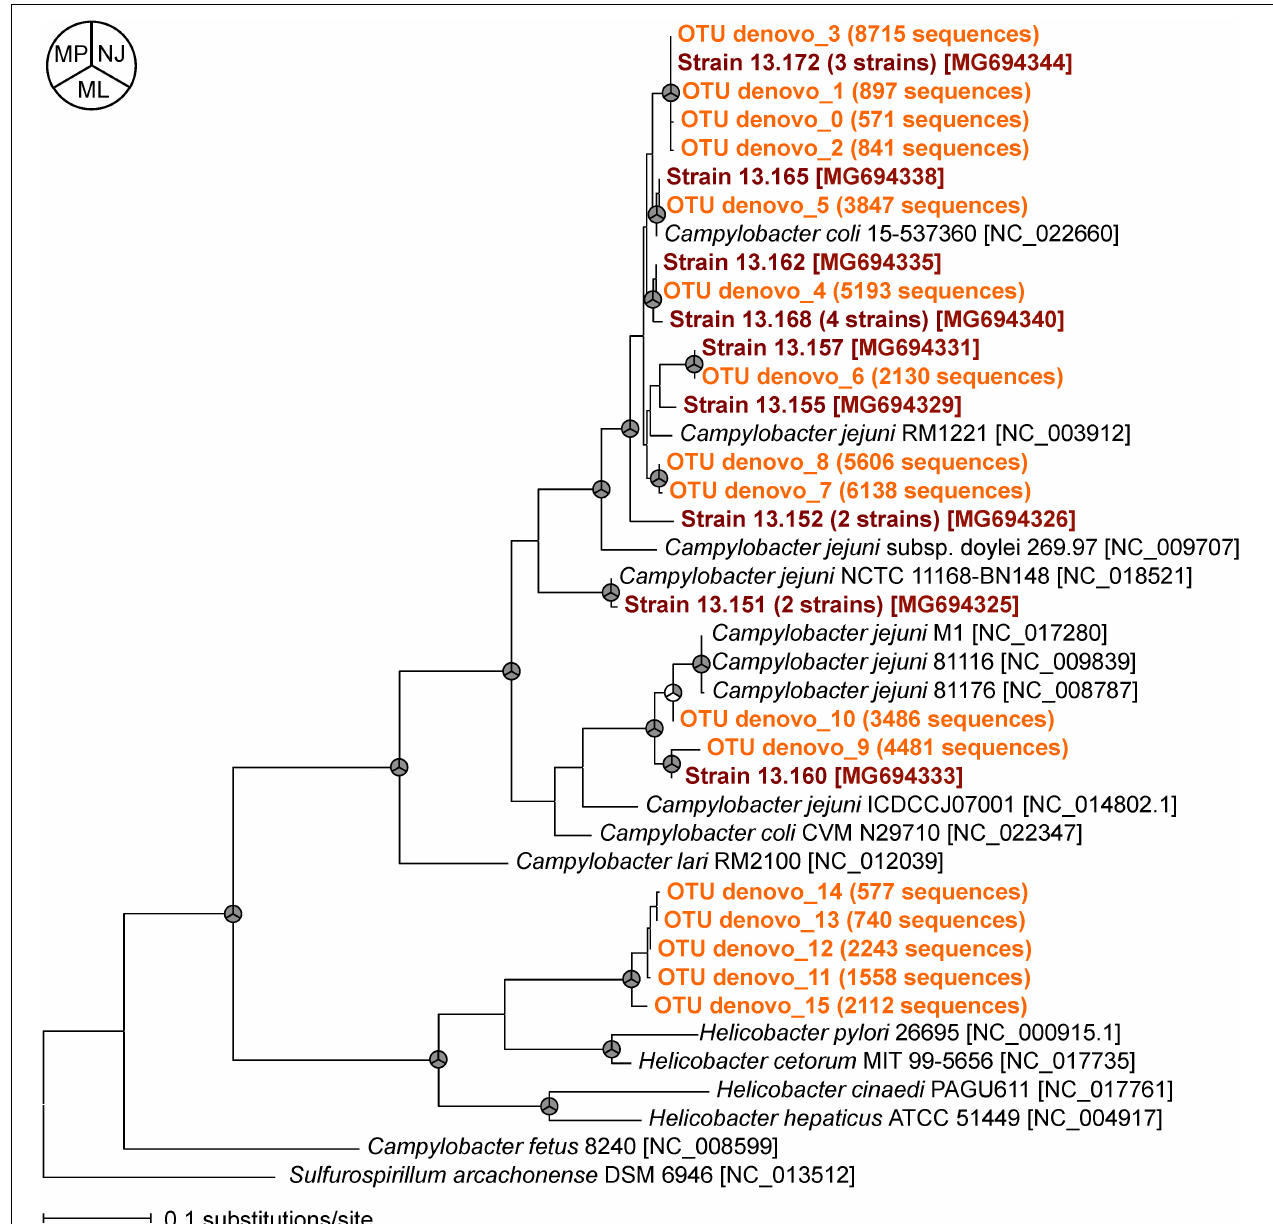
FIGURE 3 | Phylogenetic relationships between flaA SVR sequences obtained by culture-dependent method (shown in brown) and those obtained by culture-independent MiSeq analysis (shown in orange). Phylogenetic tree constructed by maximum likelihood (ML) method is shown here, but similar trees were obtained by using neighbor-joining (NJ) and maximum parsimony (MP) methods. The nodes supported by bootstrap values ( > 70%) from 1000 replicates in the phylogenetic trees constructed by NJ, ML, and MP methods are indicated as gray in the pie charts next to the branches. The accession numbers of the reference strains in the DDBJ/EMBL/GenBank databases are indicated in